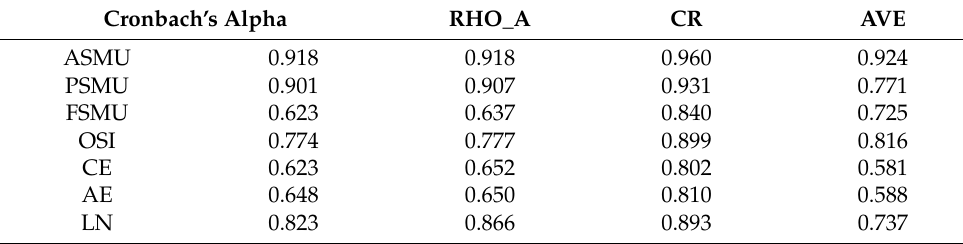
Table 1. Reliability and convergent validity.